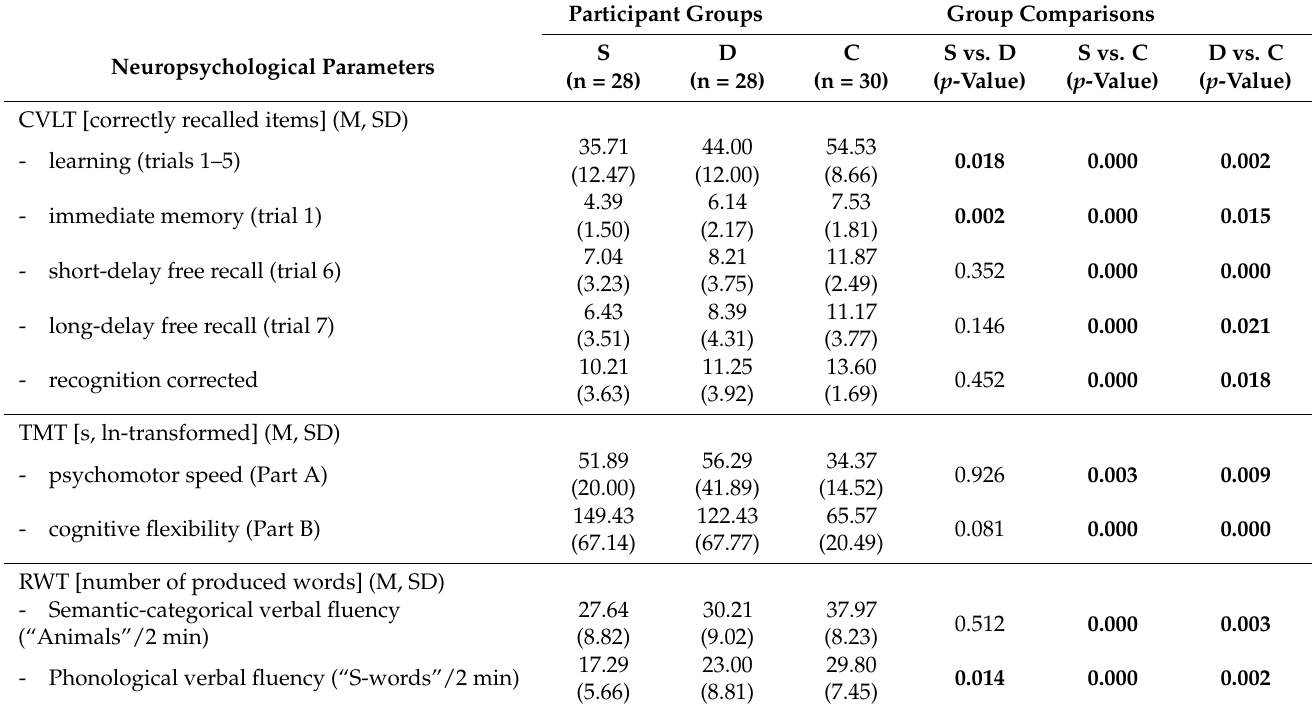
Table 2. Performance in neuropsychological background